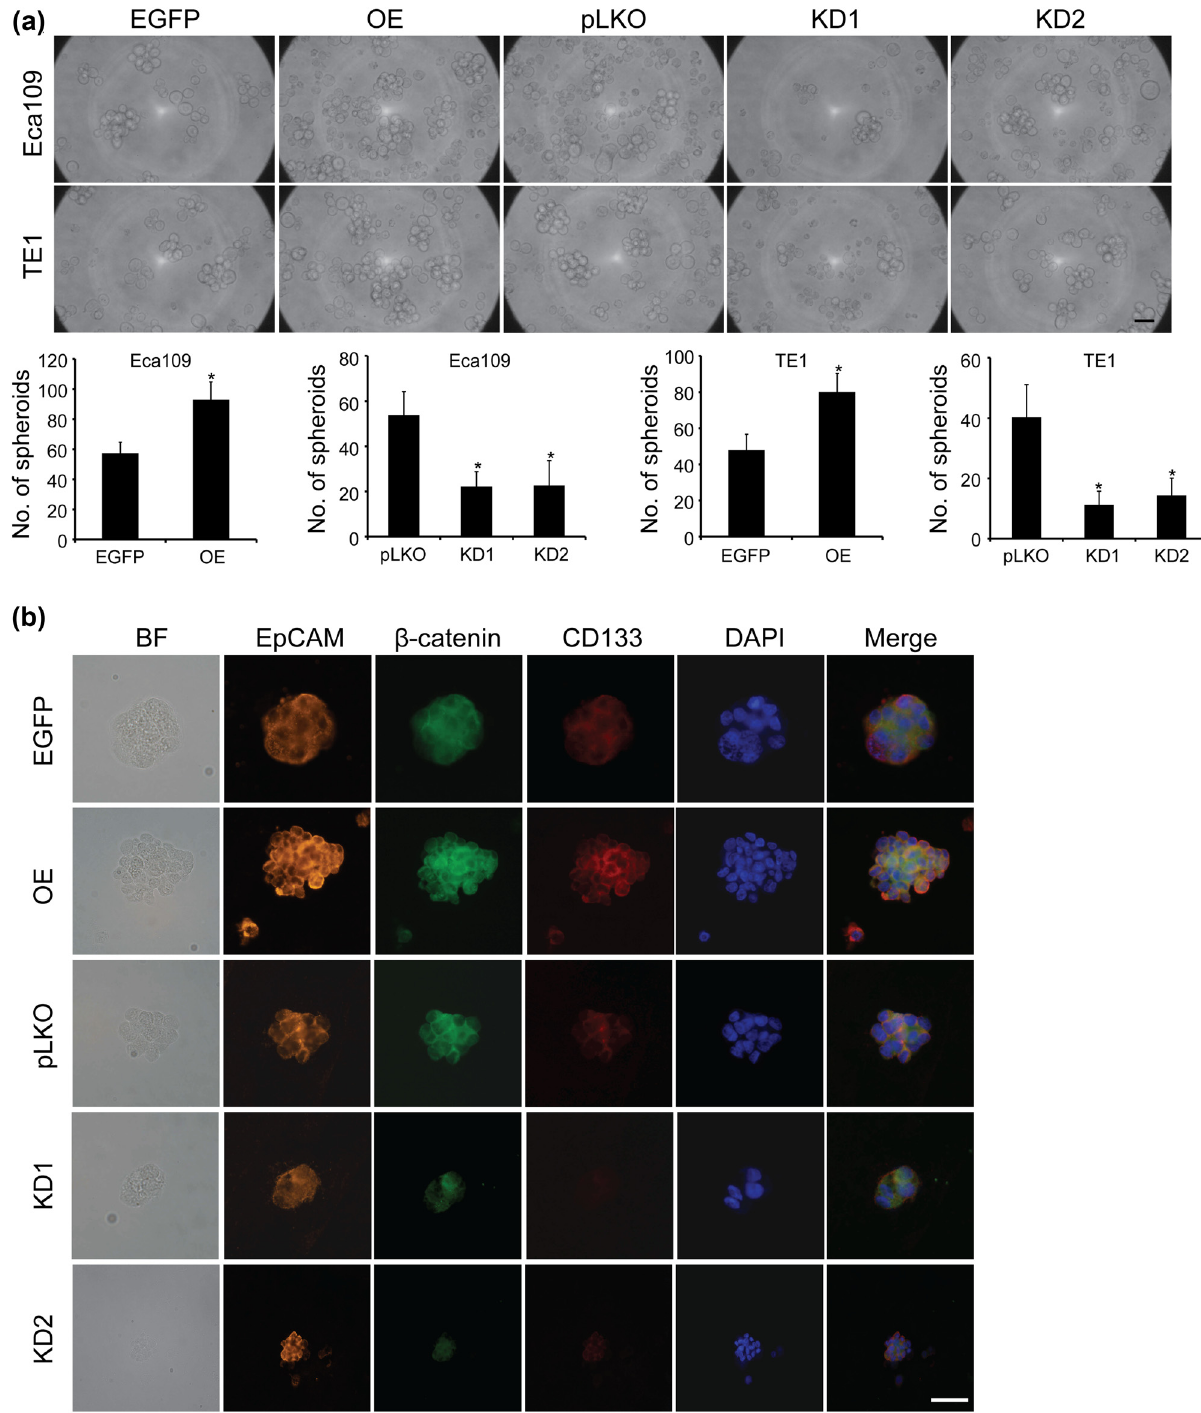
Figure 4: TET3 promotes ESCC cell spheroid formation. ( a ) Three - dimensional spheroid assay was conducted to measure the spheroidizing ability of ESCC cells. ( b ) Immuno fl uorescence of stem cell markers, including EpCAM, β - catenin, and CD133, in Eca109, scale bar = 50 μ m, * P < 0.05 vs control